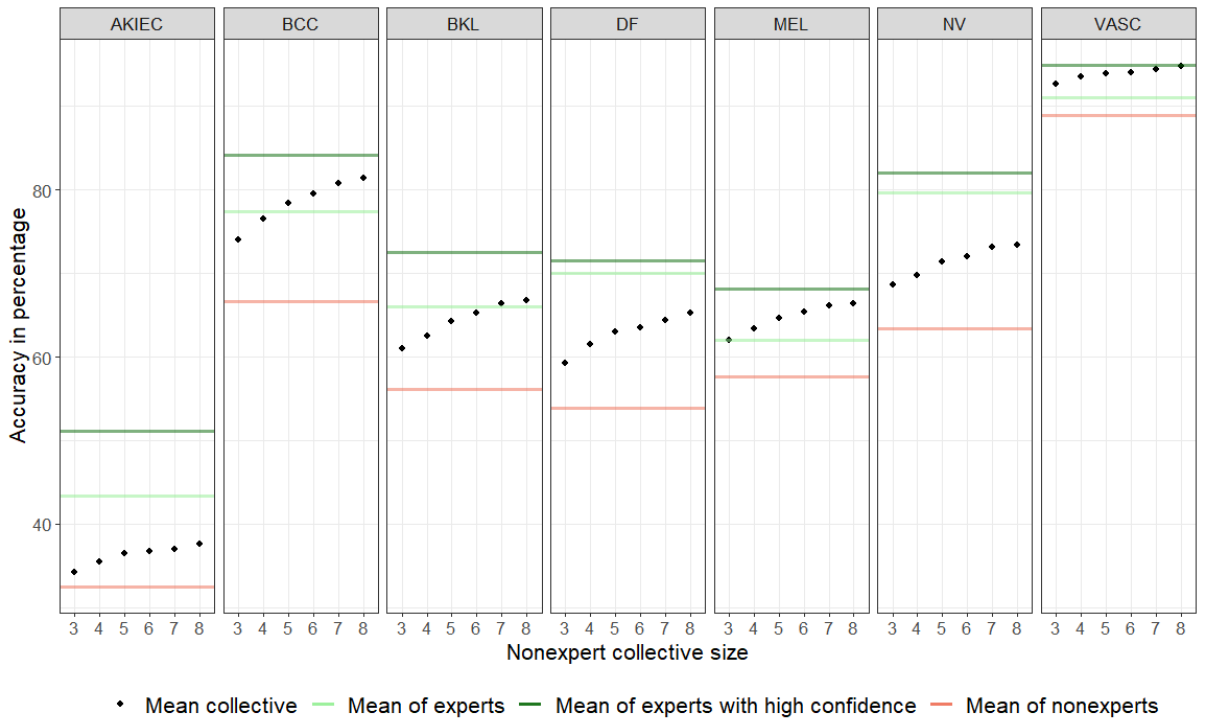
Figure 1. Mean accuracy (dots) per disease category of nonexpert collectives (ranging from 3 to 8) compared with the mean sensitivity of single experts, single experts with high confidence, and single nonexperts. AKIEC: actinic keratosis/intraepithelial carcinoma; BCC: basal cell carcinoma; BKL: benign keratinocytic lesions; DF: dermatofibroma; MEL: melanoma; NV: nevus; VASC: vascular lesions.